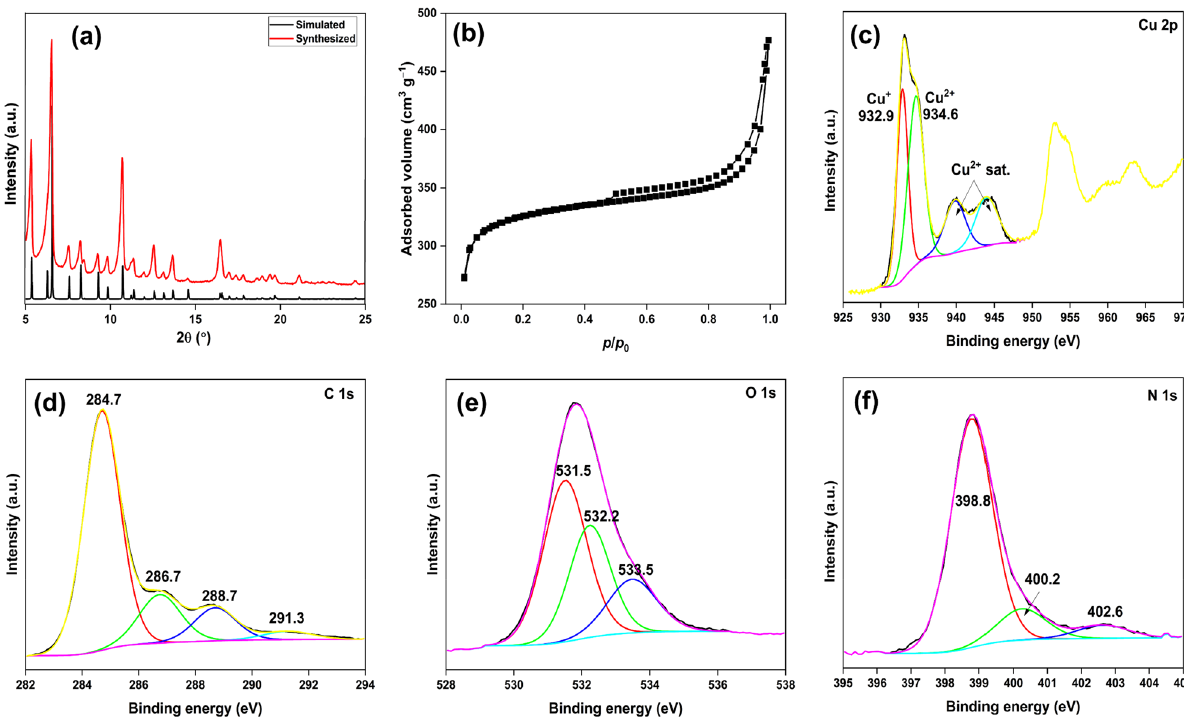
Figure 2. ( a ) PXRD pattern; ( b ) N 2 adsorption–desorption isotherm; high-resolution XPS ( c ) Cu 2p spectrum; ( d ) C 1s spectrum; ( e ) O 1s spectrum; ( f ) N 1s spectrum of